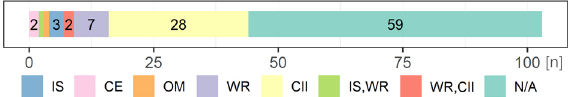
Fig. 6. Part of the Franziscean cadastre involved in the study. Fig. 7. Frequency of the supplementary data sets used. ORTO – orthophoto, MIL – Millitary